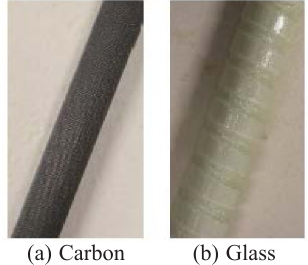
(a) Carbon (b) Fig. 2. Surface treatment of the FRP bars